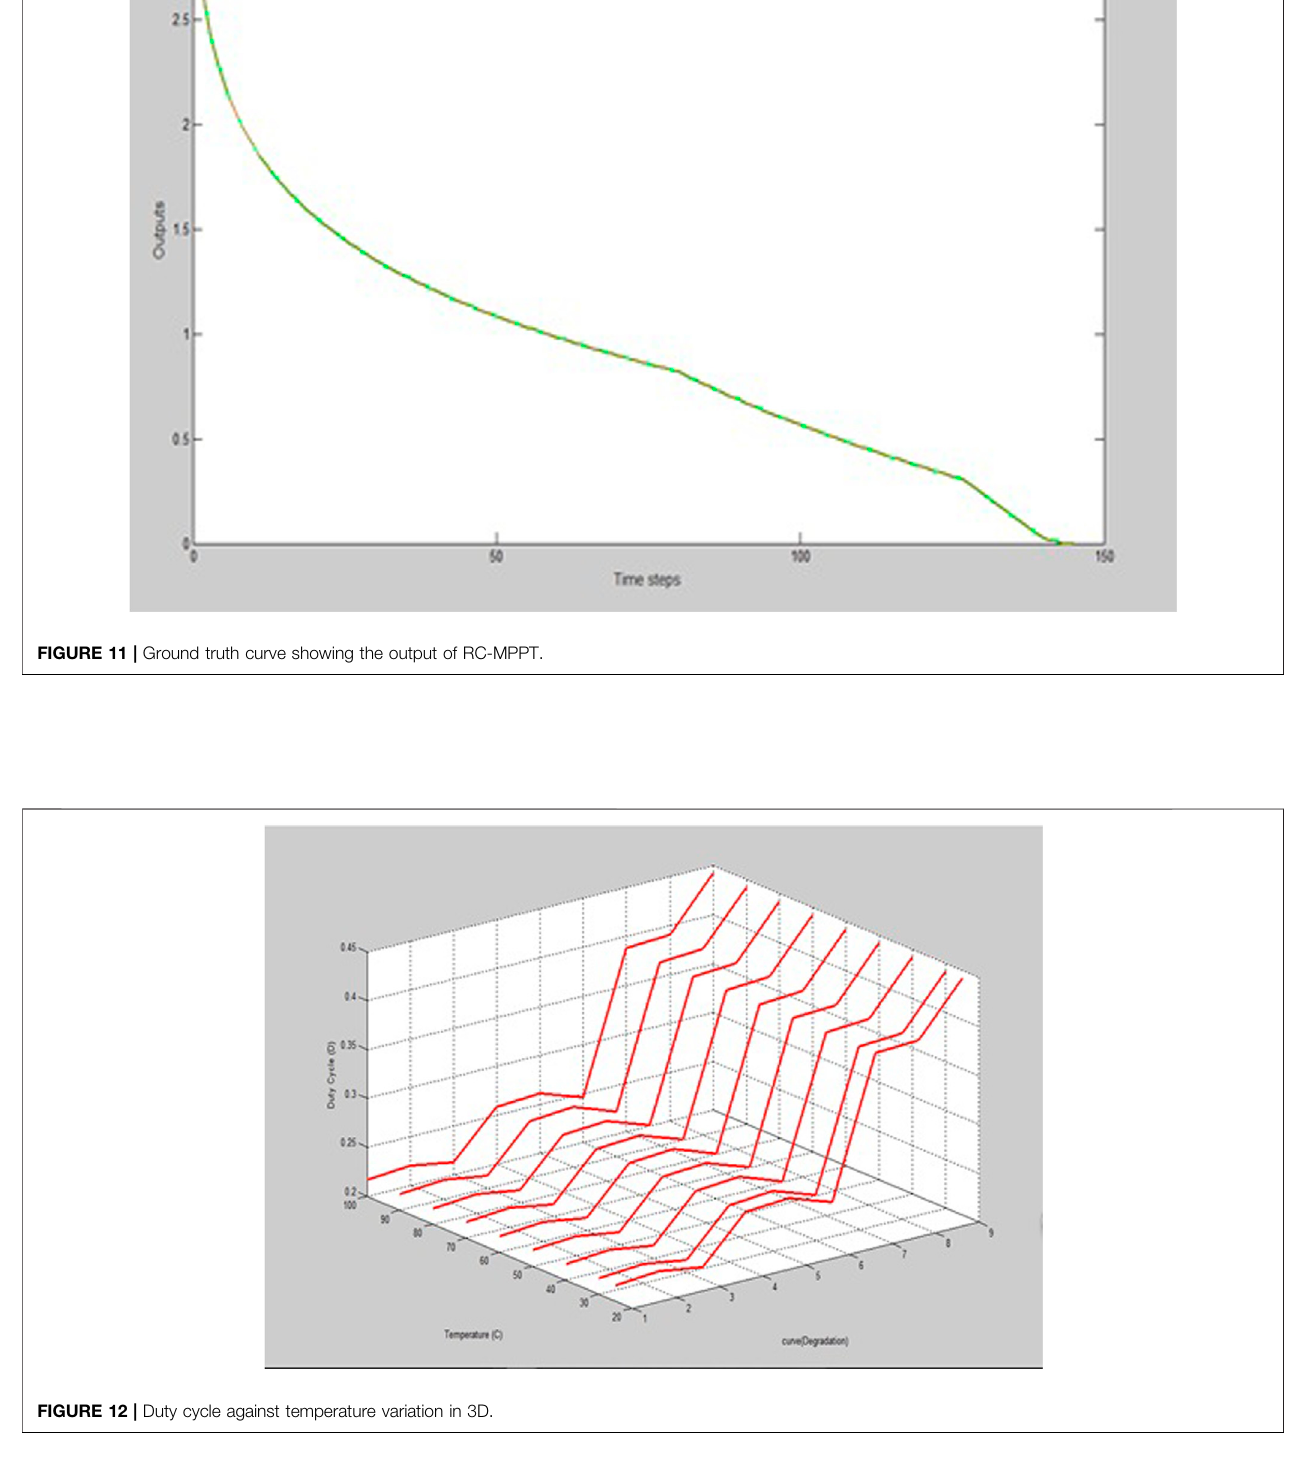
Frontiers in Energy Research |